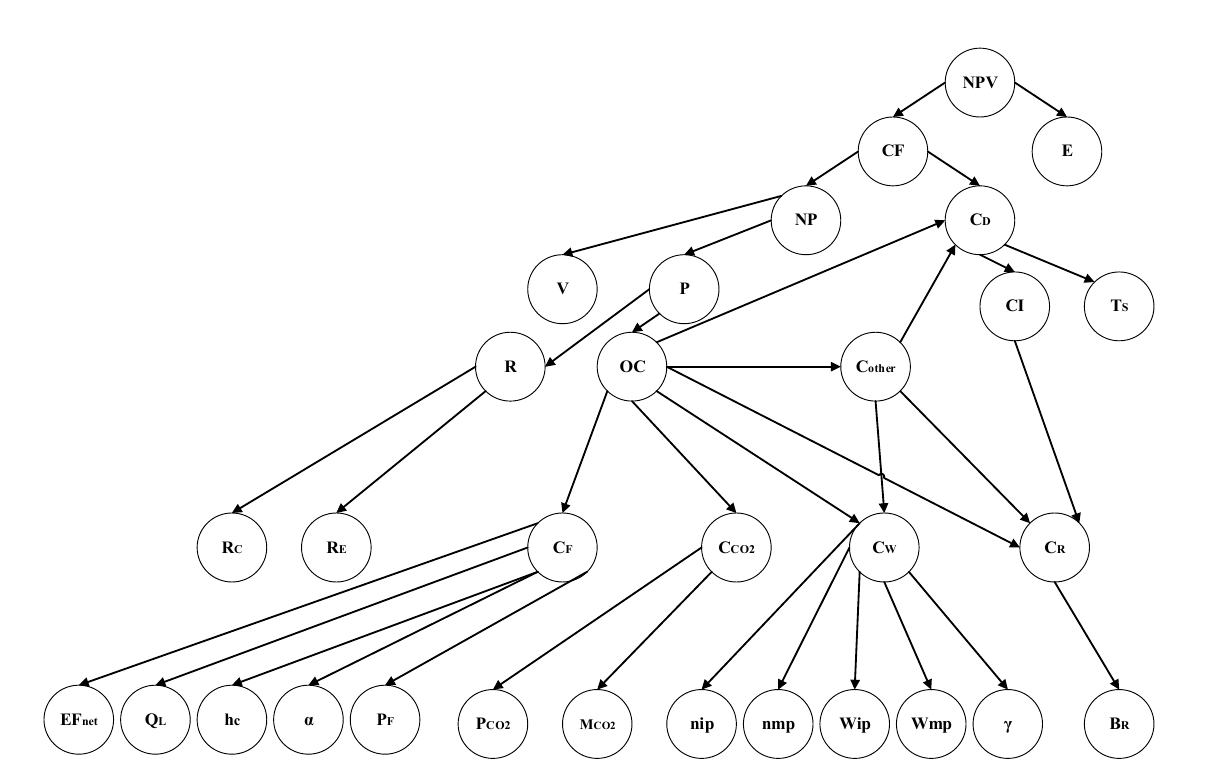
Figure 13. Analysis method diagram of the comparative financial efficiency of power plant construction, including carbon dioxide emission quotes payment.